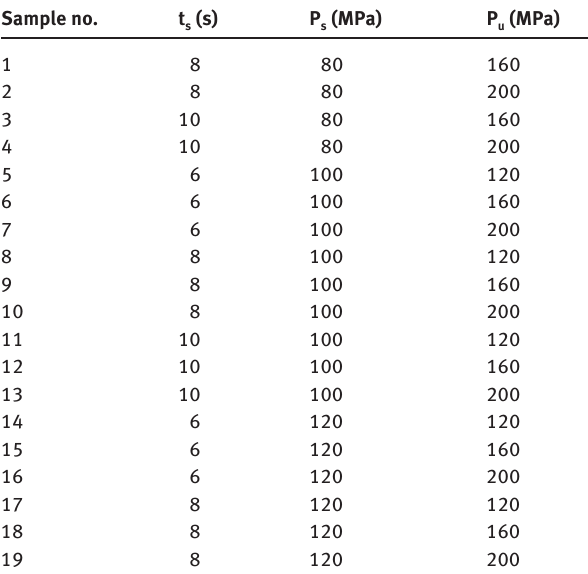
Table 3: The friction welding parameters of the AISI 316 and Ck 45 steels